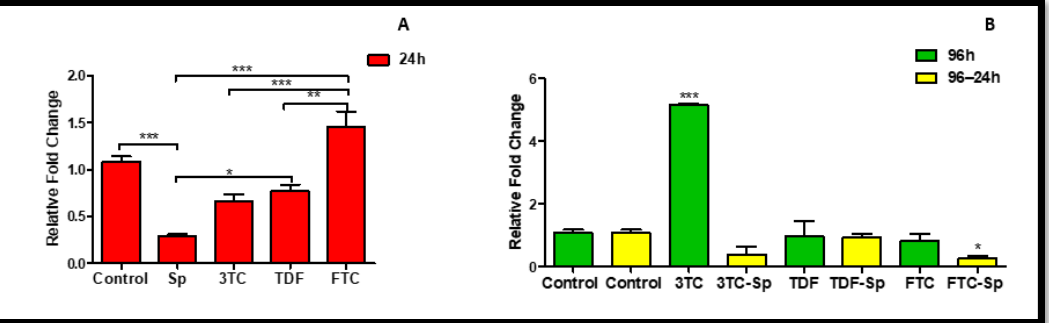
Figure 6. Effects of SP and HAART (3TC, TDF, and FTC) on JNK mRNA expression. JNK mRNA expression after exposure of HepG2 cells to ( A ) SP and HAART for 24 h, ( B ) HAART (96 h), and HAART (96 h) followed by SP (24 h); * p < 0.05, ** p < 0.005, *** p < 0.0001. 2.5. Assessment of Oxidative Stress Oxidative stress parameters were quantified in HepG2 cells via a H 2 DCF-DA assay. SP-treated cells displayed significant increased levels of intracellular ROS, while HAART also induced a significantly abnormal increase in intracellular ROS following acute and prolonged exposure, with only 3TC (96 h) indicating a significant decrease A: ( p < 0.0001), B: ( p < 0.0001). Interestingly, SP managed to reduce access ROS induced by prolonged exposure to HAART, specifically there was a positive synergistic effect, B: ( p < 0.0001) (Figure 7).